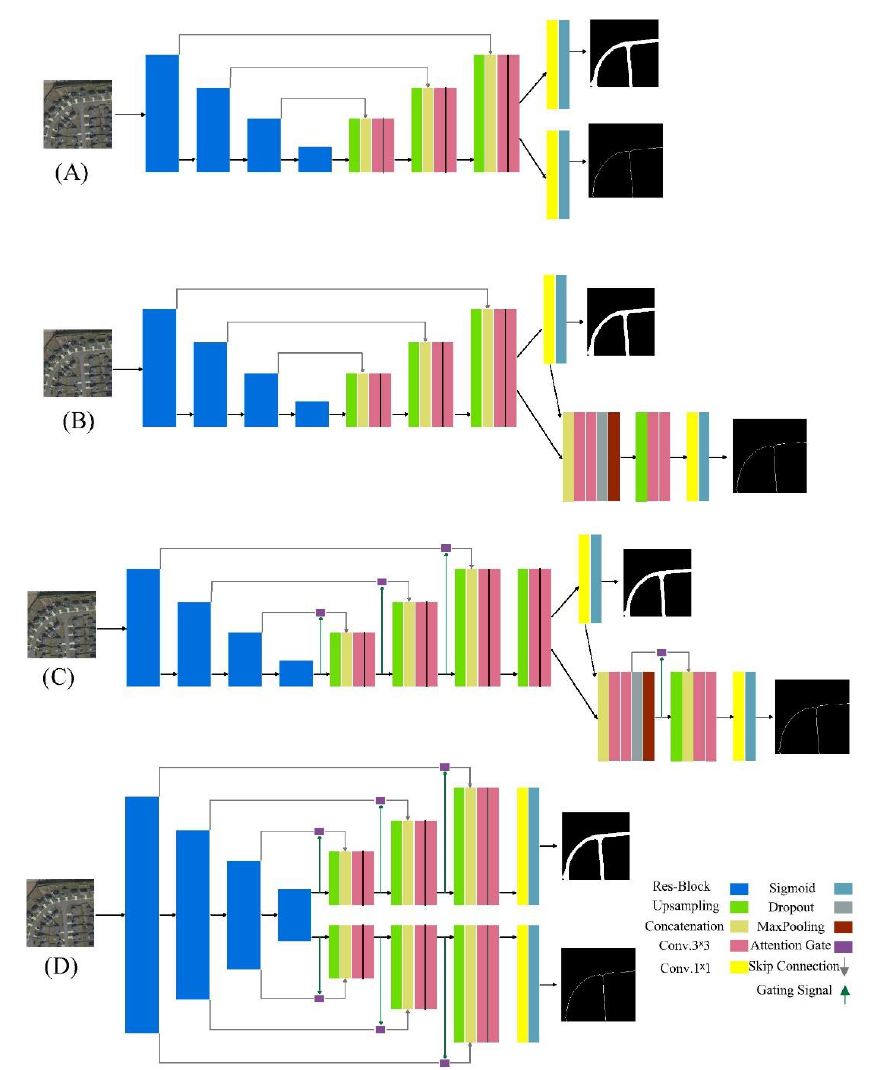
Figure 2. The proposed MTL models considered in this study, ( A ) MTL model by two branches, ( B ) MTL by two models, ( C ) MTL by two models with attention gates, and ( D ) MTL by one encoder and two decoders with attention